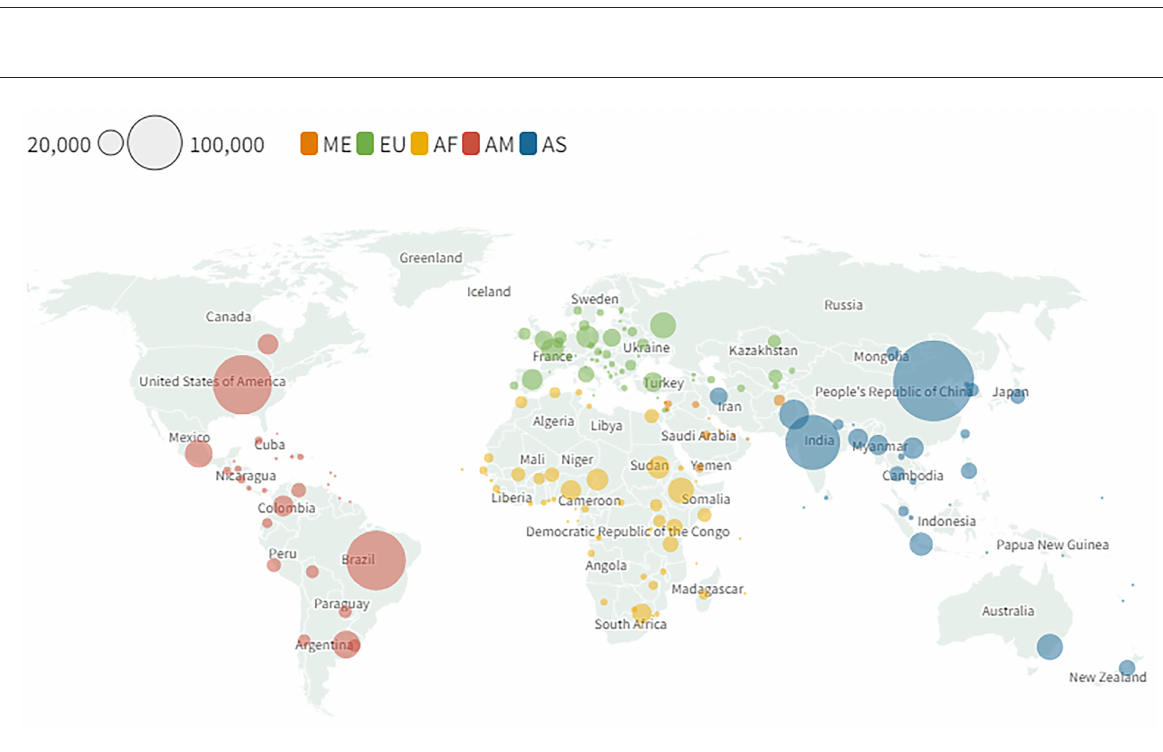
FIGURE2 Global distribution of livestock biomass (including terrestrial and aquatic animals) in thousands of tons for the year